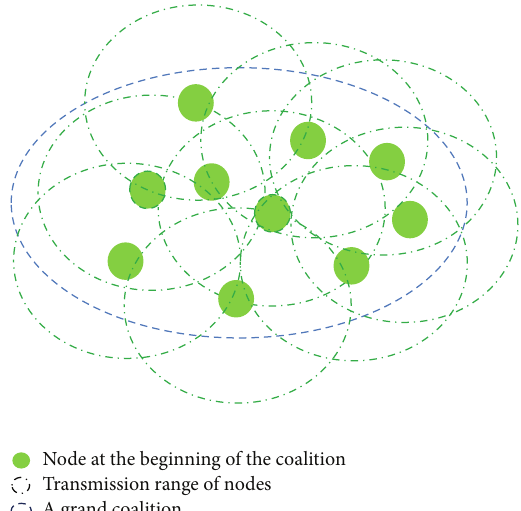
Figure 1: A coalition of ten (10) nodes with no malicious node.